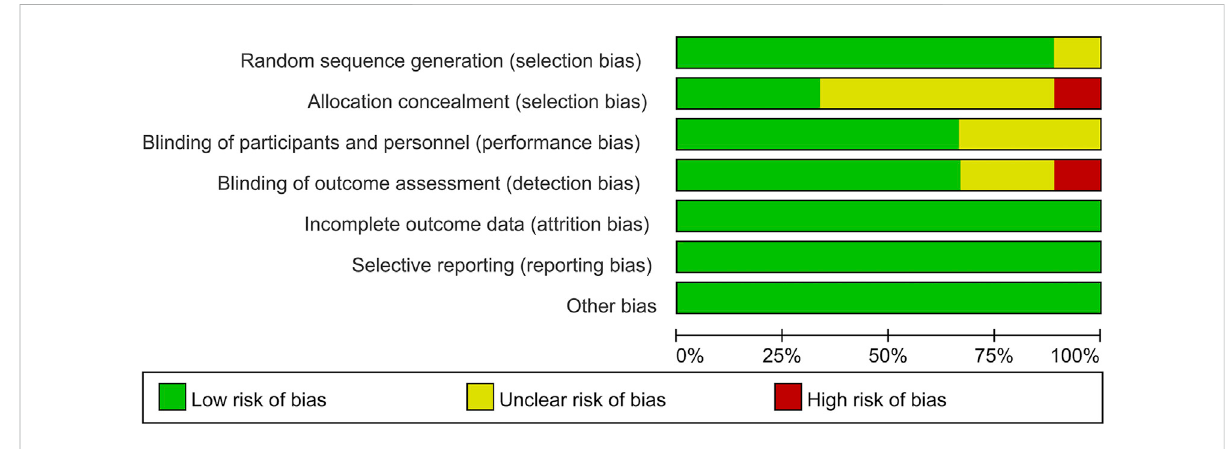
FIGURE 3 Risk of bias graph: each risk of bias item is presented as the percentage across all the included studies, which indicates the proportion of different levels of risk of bias foreach